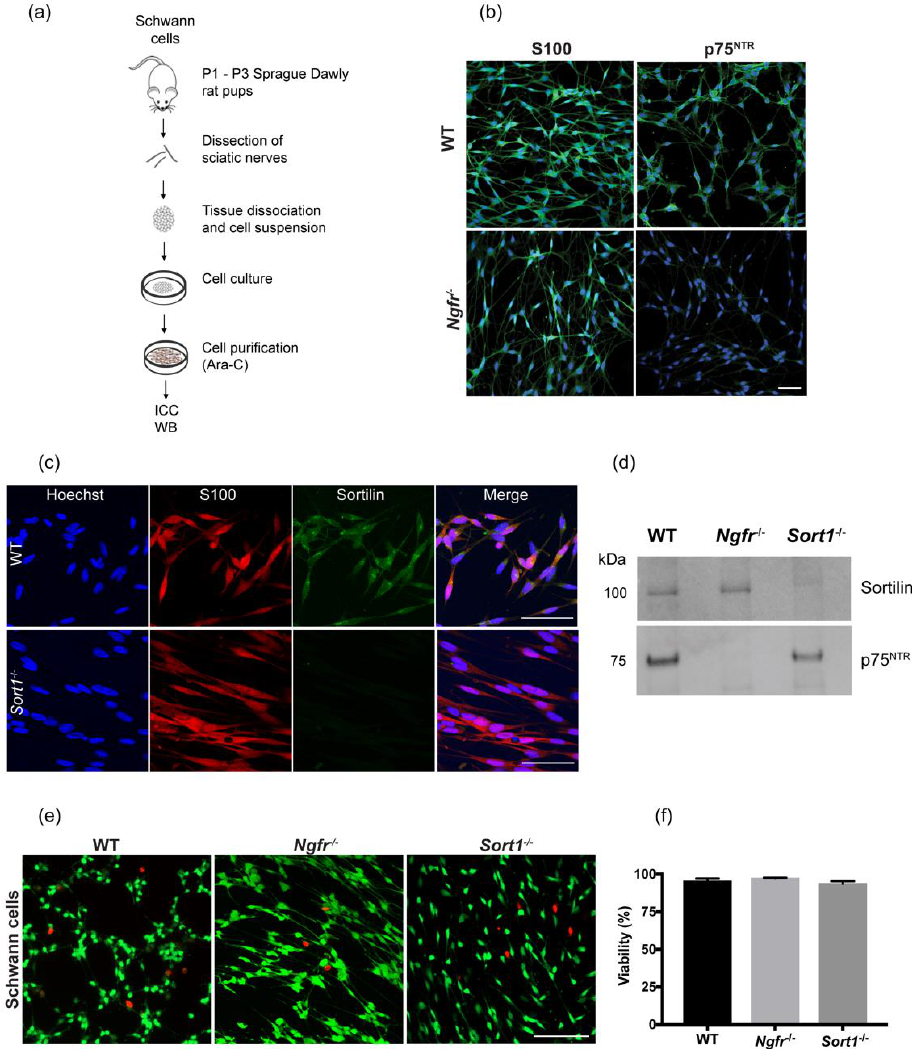
Figure 1. Primary Schwann cell (SC) characterization. ( a ) Schematic representation of the cell isolation strategy used. ( b ) Depiction of SC primary culture with immunocytochemistry against S100 and p75 NTR (both in green) in primary SCs from wild-type (WT) or Ngfr − / − neonatal rats. Images show lack of p75 NTR staining in Ngfr − / − derived cells. Nuclei are labeled in blue with Hoechst. Scale bar 50 μ m. ( c ) Double immunocytochemistry between sortilin (red) and S100 (green) for both WT and Sort1 − / − derived primary SCs. Hoechst was used to label the cell nuclei (blue). Scale bar 50 μ m. ( d ) Representative immunoblot for sortilin and p75 NTR from primary SC lysates, validating sortilin or p75 NTR protein absence in Sort1 − / − or Ngfr − / − primary SCs, respectively. ( e ) Live and death assay where viable cells were identified in SC cultures by Calcein green fluorescence, while dead cells were labeled red by ethidium homodimer-1. Scale bar 10 0 μm ( f ) Quantification shows that viability of Ngfr − / − or Sort1 − / − SCs is similar to that of WT SCs.